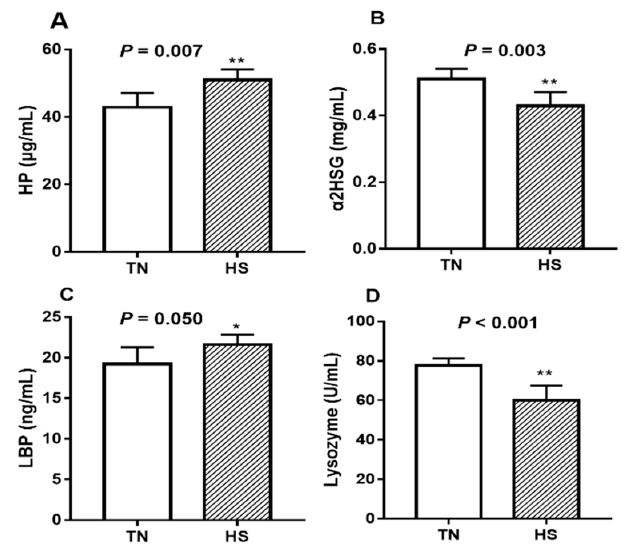
Figure 2. The effects of three weeks of thermal neutral (TN) or heat stress (HS) conditions on activities of ( A ) HP, ( B ) α 2HGS, ( C ) LBP, and ( D ) lysozyme in the serum of finishing pigs. Data are mean ± SD; n = 8 for each group. * p < 0.05 and ** p < 0.01 before vs. after heat stress.